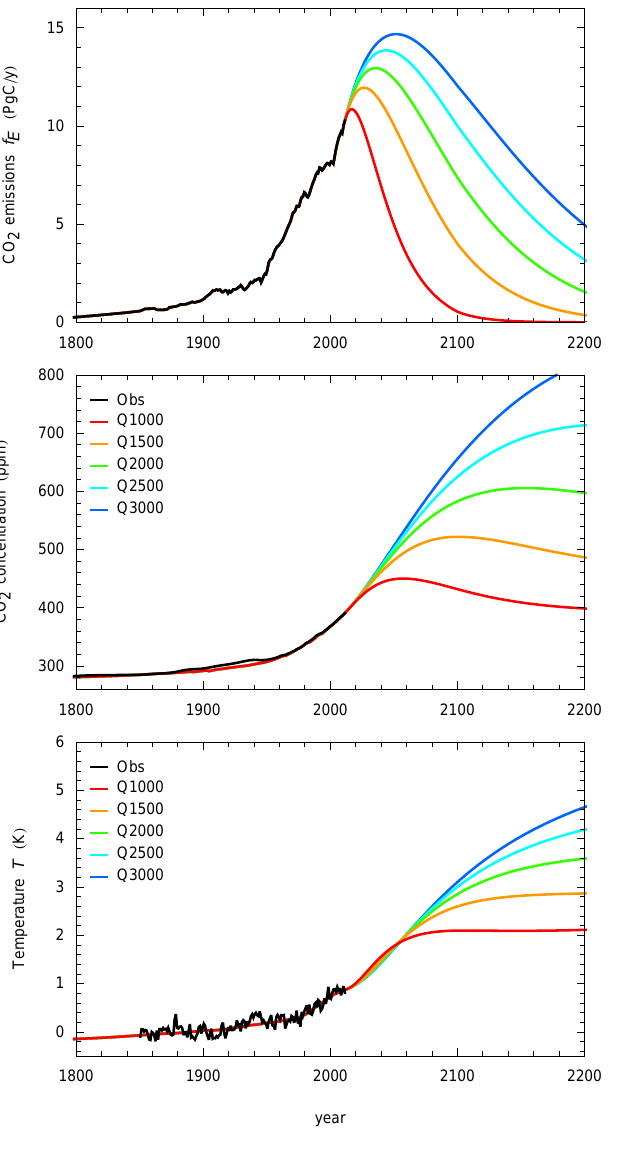
Fig. 6. Total CO 2 emissions ( f E ) and predictions for CO 2 concentration and temperature T , with analytic emission scenarios for CO 2 and non-CO 2 gases yielding cumulative total CO 2 emissions Q E ( ∞ ) from 1000 to 3000PgC (details in Appendix B). Left and right panels show plots against time and Q E (t) , respectively. In lower right panel, large points are IPCC AR4 projections (IPCC, 2007) for T (Q E ) in 2100 for SRES marker scenarios (from left) B1, A1T, B2, A1B, A2, A1FI, with 17–83% uncertainties; small points are C4MIP projections (Matthews et al., 2009). Data sources: Appendix